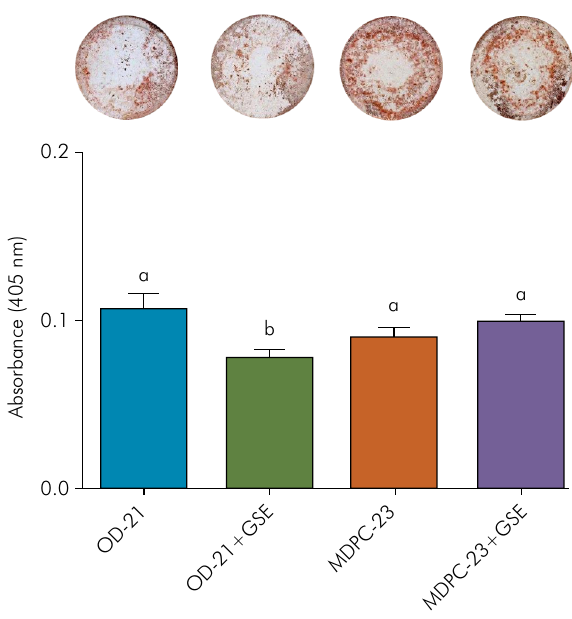
Figure 4. Detection and quantification of OD-21 and MDPC-23 mineralization after 14 days. Different letters mean statistical difference set at 5% (ANOVA).